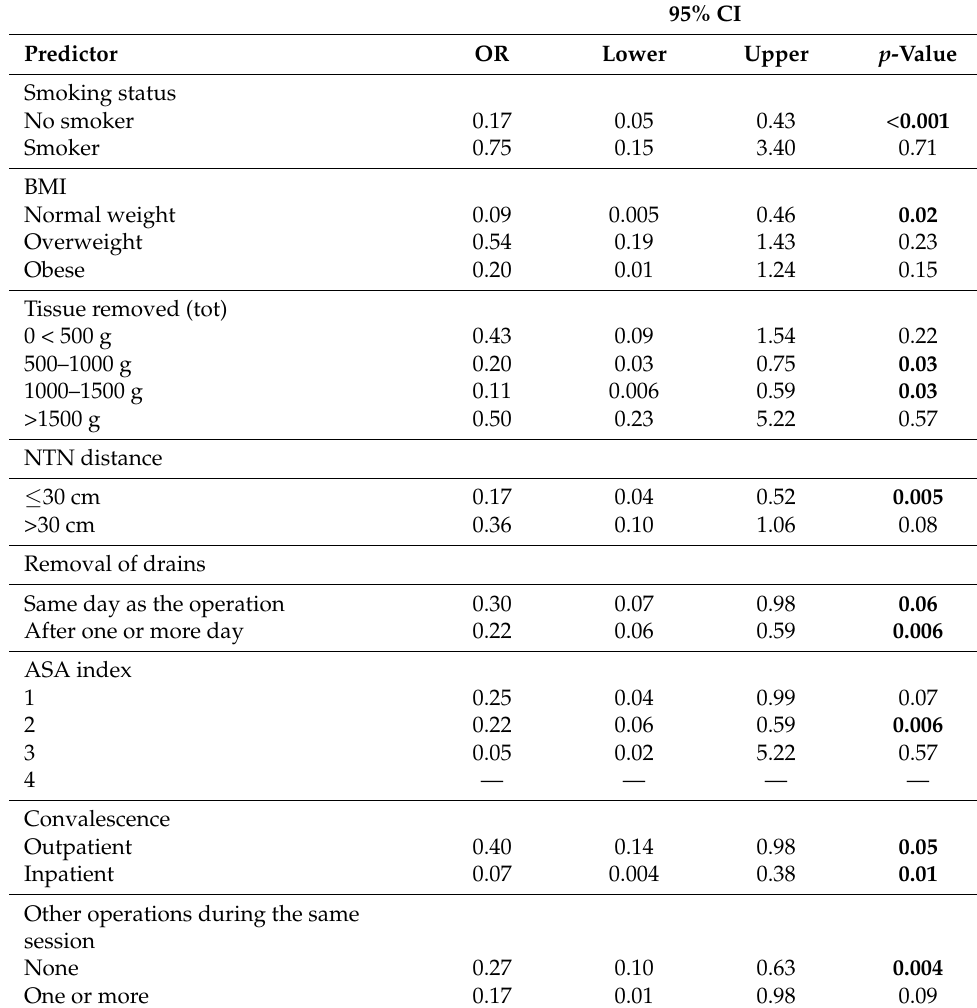
Table 3. Univariate Odds Ratios ( N =